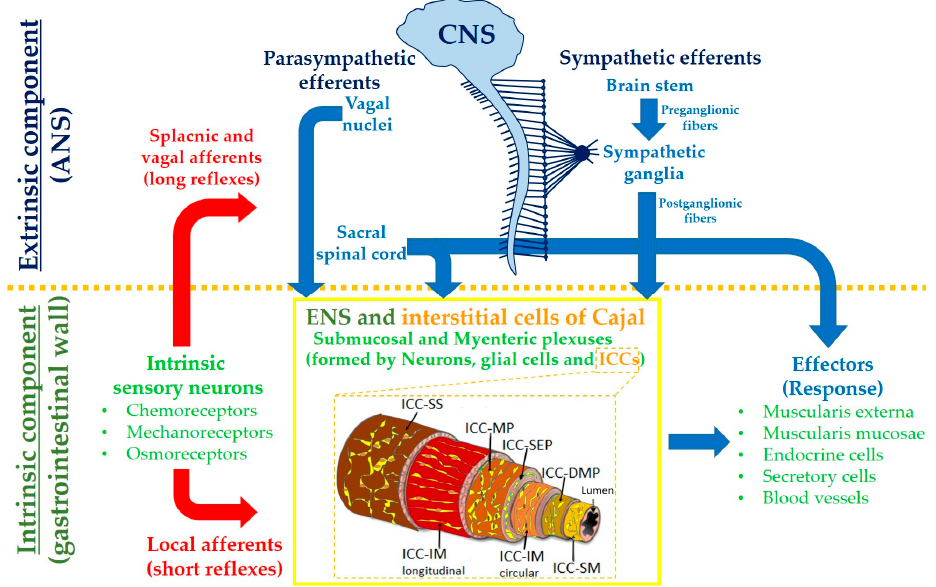
Figure 2. Representation of link between central nervous system (CNS), autonomic nervous system (ANS) and enteric nervous system (ENS). Location of interstitial cells of Cajal (ICCs) sub-types according to the gastrointestinal layer. ICC-SM: ICC of submucosa; ICC-DMP: ICC of deep muscle plexus; ICC-IM: ICC of intramuscular layer; ICC-MP: ICC of myenteric plexus; ICC-SS: ICC of sub-serosa. Modified from [11].